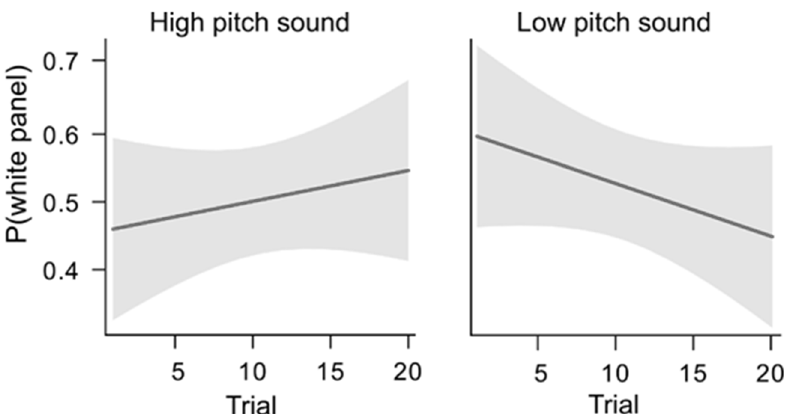
Figure 4. Results from Experiment 2: Chicks underwent 10 consecutive trials with high pitch and 10 consecutive trials with low ‐ pitch background audio. In both cases, there was no significant preference for a specific luminance (i.e., white vs. black panel). On the y ‐ axis is the probability of choosing the white panel. The shaded area indicates 95% confidence intervals.